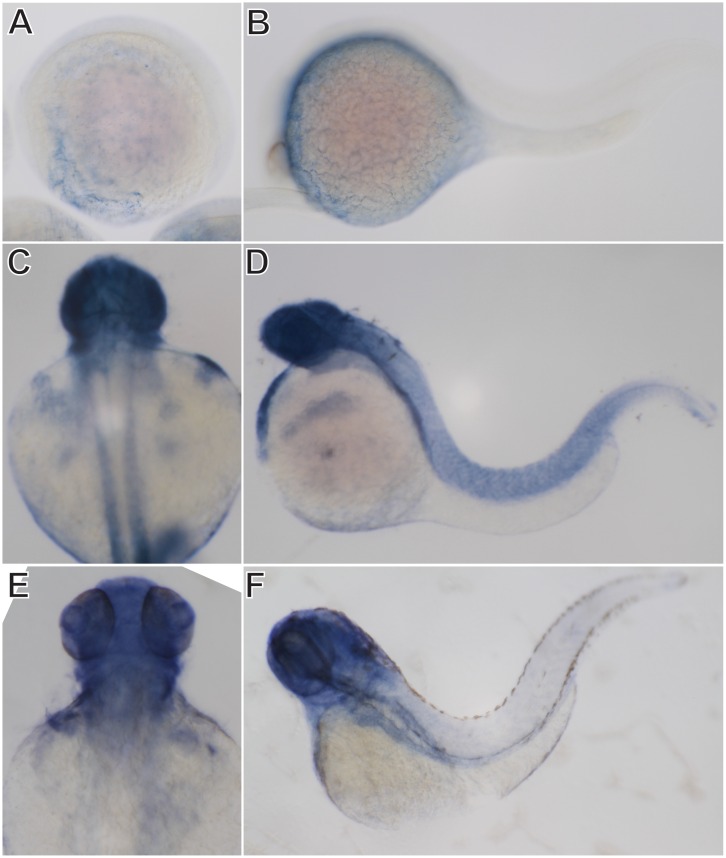
Expression patterns of zebrafish soat2 during embryogenesis.Whole-mount in situ hybridization shows that soat2 can be detected at yolk sac at 12 hpf (A) and 24 hpf (B). By 48 hpf (C, D), soat2 was detected in the brain, retina, yolk sac, hatching gland, pericardium and intersomitic regions. By 72 hpf (E, F), soat2 was also observed in the liver primordial and intestine.